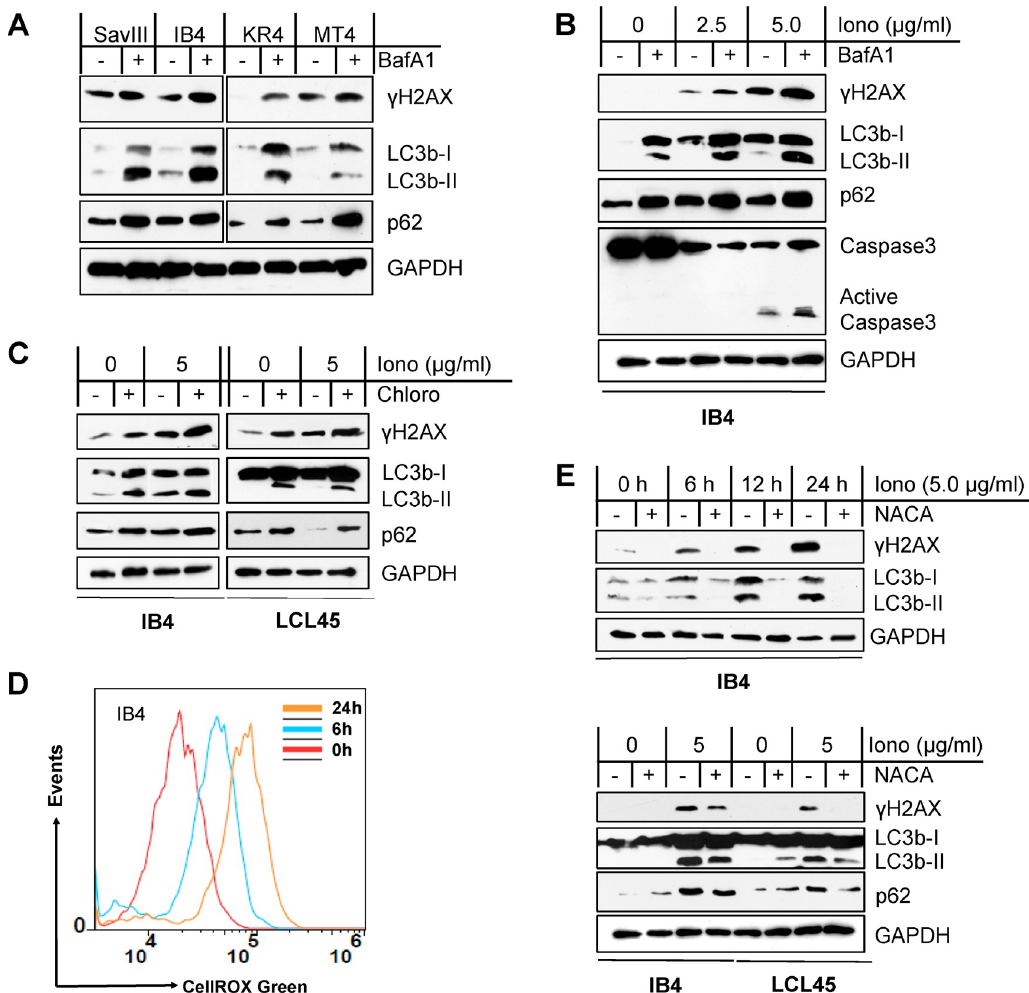
(BafA1) (Sigma) or vehicle control for 24 h, and then DNA damage ( γ H2AX) was evaluated by immunoblotting. B-C . The LCL lines IB4 and LCL45 were treated with ionomycin (Iono) (Sigma) with indicated concentrations for 48 h plus 0.4 µ M BafA1 or vehicle control for 24 h or plus 50 µ M of the lysosome inhibitor chloroquine (Chloro) (MP Biomedicals) or vehicle control for 6 h. p62, autophagy, and γ H2AX were analyzed by immunoblotting. D . IB4 cells were treated with 5 µ g/ml Iono or vehicle control for different time periods, and ROS production was measured by flow cytometry with the CellRox Green reagent (Invitrogen). A representative result from three independent repeats is shown. E . IB4 and LCL45 cells were treated with 5 µ g/ml Iono plus 3 mM NACA or vehicle control for different time periods (upper panel) or for 30 h (lower panel). p62, autophagy, and γ H2AX were analyzed by